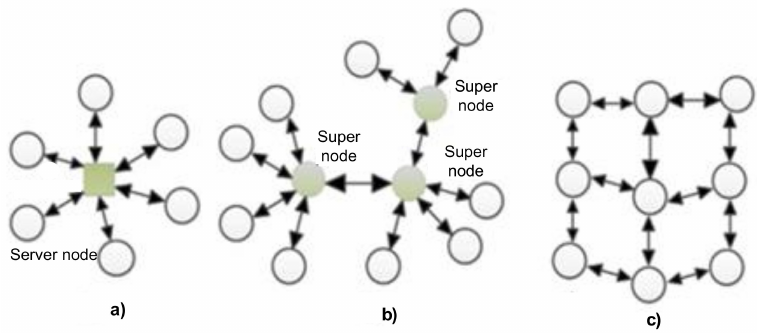
Figure 9. Types of EMS control: ( a ) centralized, ( b ) decentralized, ( c ) distributed.